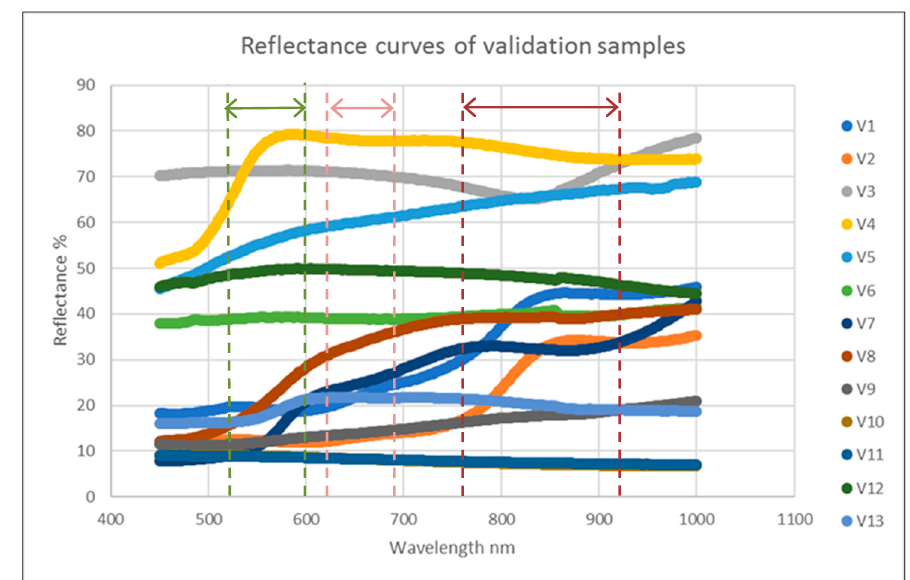
Figure 8. Validation samples reflectance curves 450–1000 nm at 2.5 nm intervals.